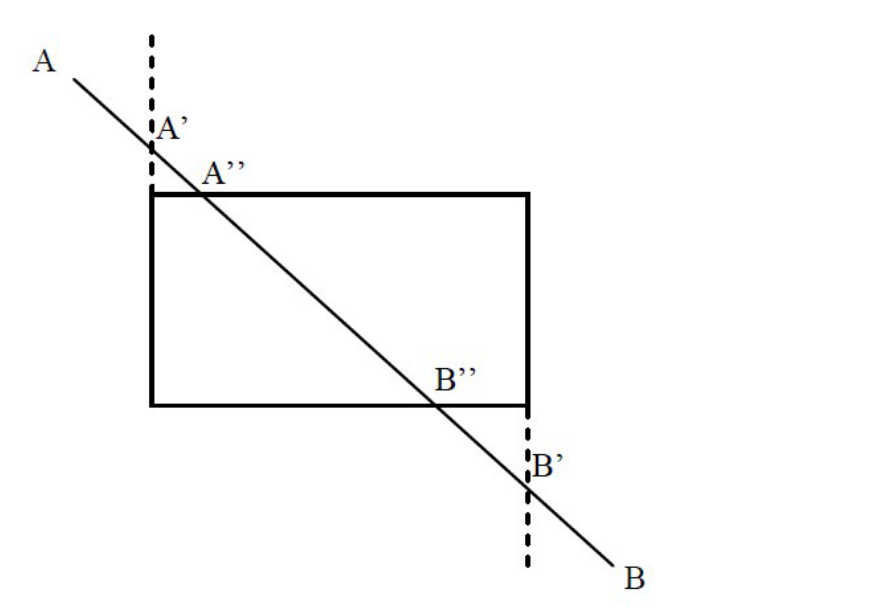
Figure 21. Line is intersecting the boundaries; The new line endpoints A (cid:48)(cid:48) and B (cid:48)(cid:48) have been calculated.